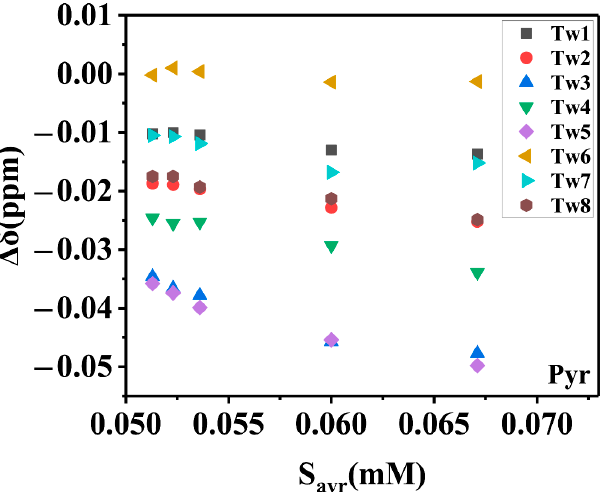
Figure 5. Relative chemical shifts ( ∆δ ) of Tween 80 protons as a function of S avr in the single Pyr system at Tween 80 concentrations from 10 to 50 mM compared to those of the pure Tween 80 solution at the same concentration.